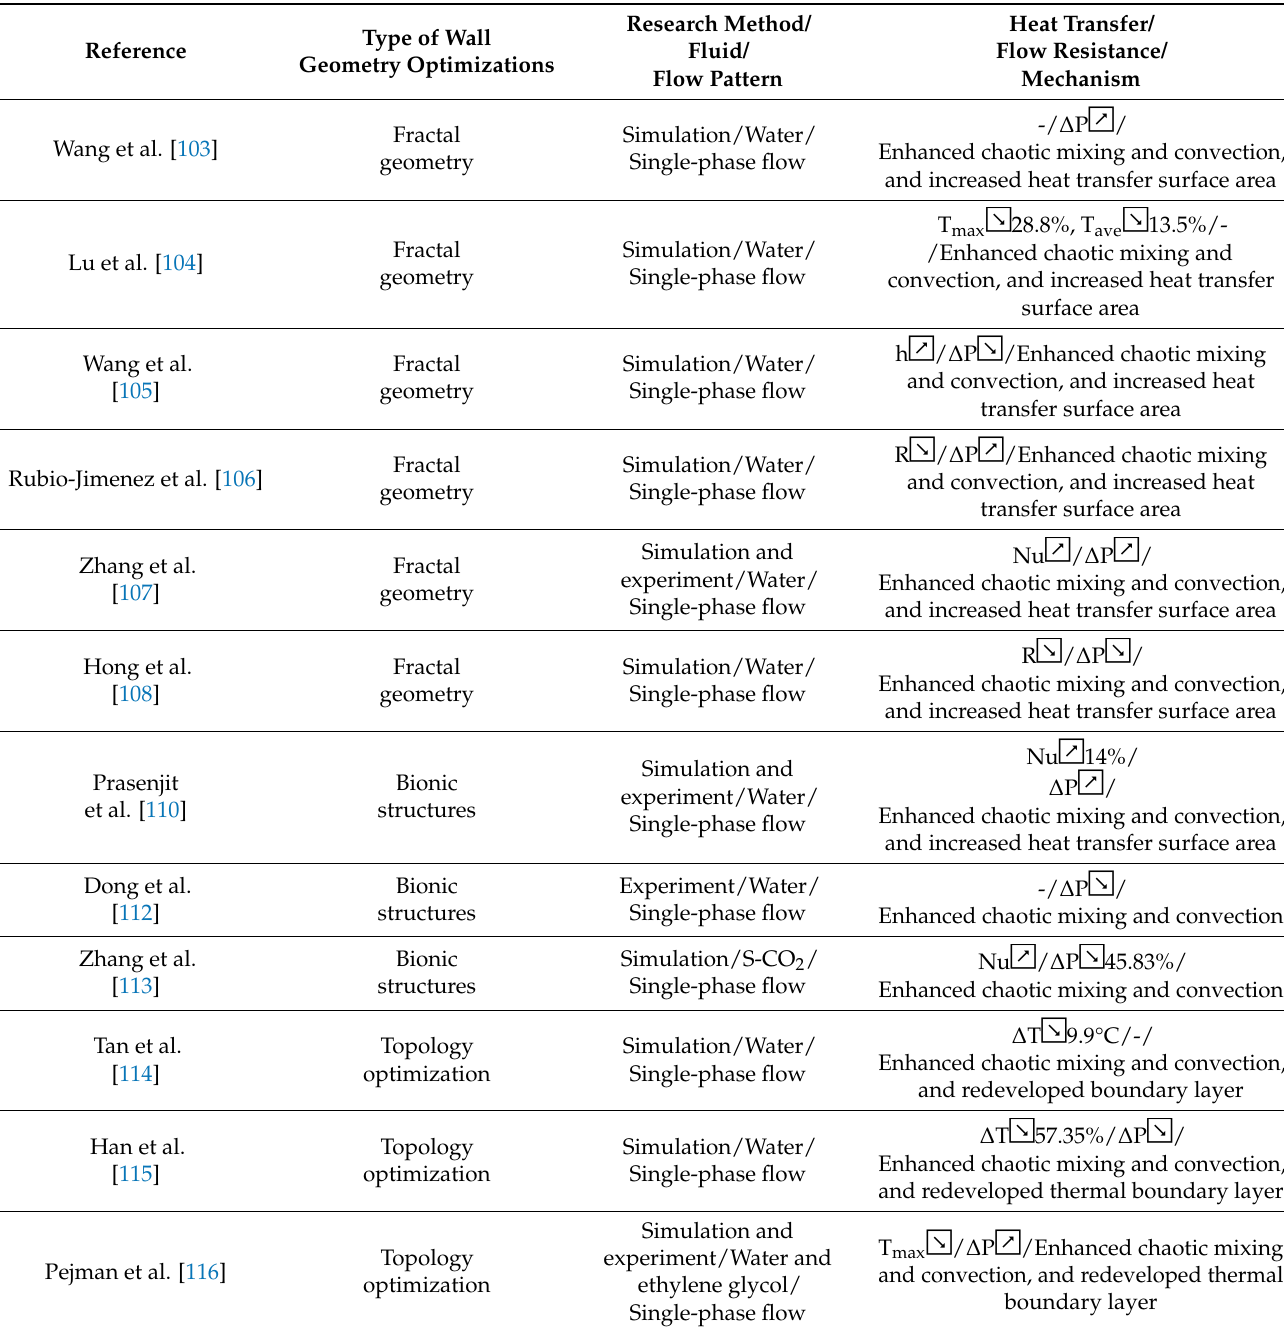
Table 3. Selected studies of geometric optimization on sidewall and bottom wall of the microchan- nel on heat transfer.